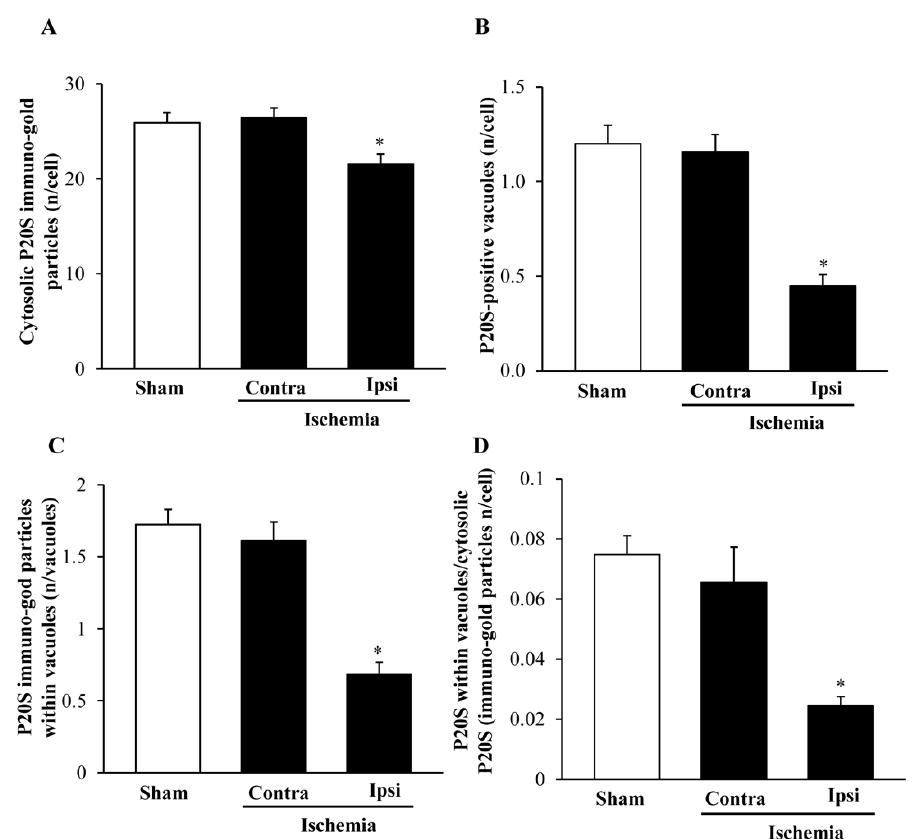
Figure 15. Ultrastructural morphometry of P20S within dorsal regions. Graphs report the ultrastructural morphometry for P20S from dorsal area penumbra (Ipsi/Ischemia, n = 6) and homologous regions from the contralateral side (Contra/Ischemia, n = 6) or from sham-operated mice (Sham, n = 6). Values were reported as the mean ± S.E.M. per cell from a total of 120 cells for each group. * p ≤ 0.05 compared with other groups. ( A ) df = 2, F-value = 6.403, p = 0.098; ( B ) df = 2, F-value = 25.297, p < 0.0001; ( C ) df = 2, F-value = 27.547, p < 0.0001; ( D ) df = 2, F-value = 11.257, p = 0.001.